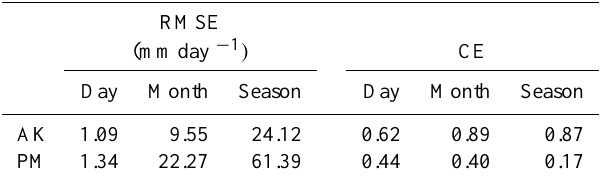
Table 5. Test performance of the AK and PM models in daily, monthly and seasonal